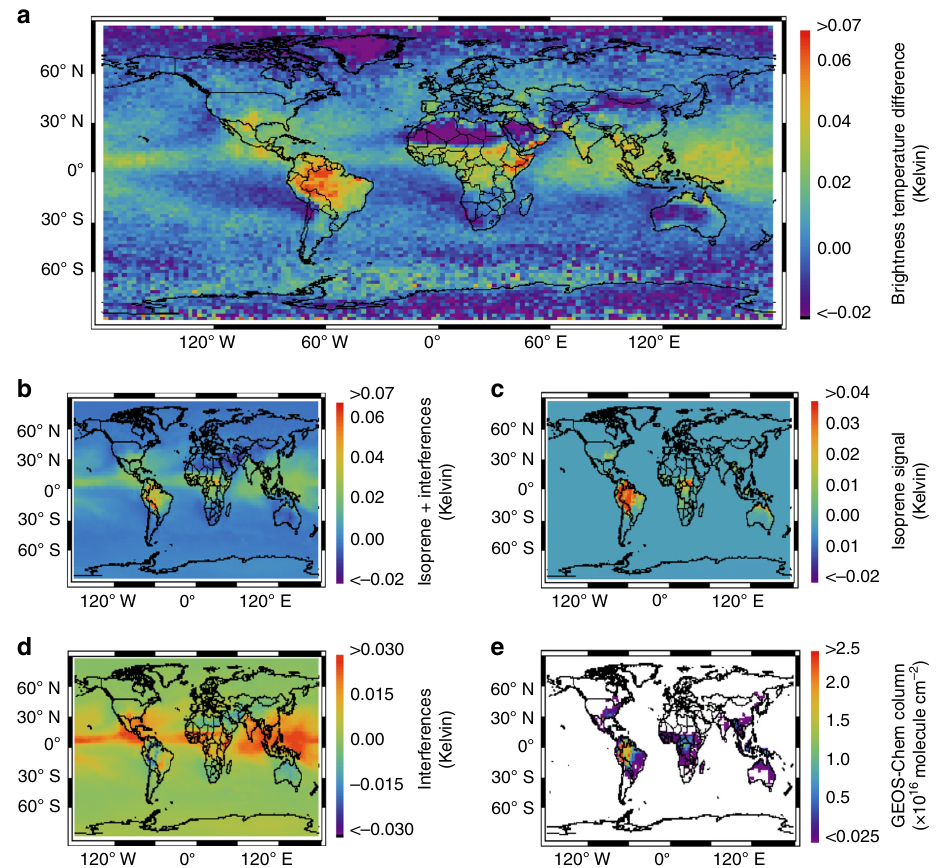
Fig. 2 Accounting for spectral interferences in the quanti fi cation of isoprene. a CrIS brightness temperature differences ( Δ T b ) for September 2014 (daytime, cloud-screened data only) mapped on a 2.0° × 2.5° latitude – longitude grid. Δ T b values are calculated as the spectral difference between the peak of absorption and proximate near-continuum data for the isoprene ν 28 band. b Simulated Δ T b distribution predicted based on GEOS-Chem model isoprene columns for the same month. c Simulated brightness temperature differences at the peak of the ν 28 isoprene absorption ( Δ T ν 28 ) between an isoprene-free atmosphere and an atmosphere containing the GEOS-Chem isoprene distribution, based on an observing system simulation experiment. Panel c represents the spectral signal in the CrIS data arising purely from isoprene that would be expected given the GEOS-Chem isoprene distribution. d Difference between panels ( b ) and ( c ). Panel d represents the contributions from interfering species to Δ T b when calculated from the on-peak ( ν 28 ) vs. off-peak radiances as in panels ( a ) and ( b ). e Isoprene column densities (10 16 moleculecm − 2 ) predicted by GEOS-Chem for the same month and spatial western Brazil) and with nonisoprene interferences (e.g., over